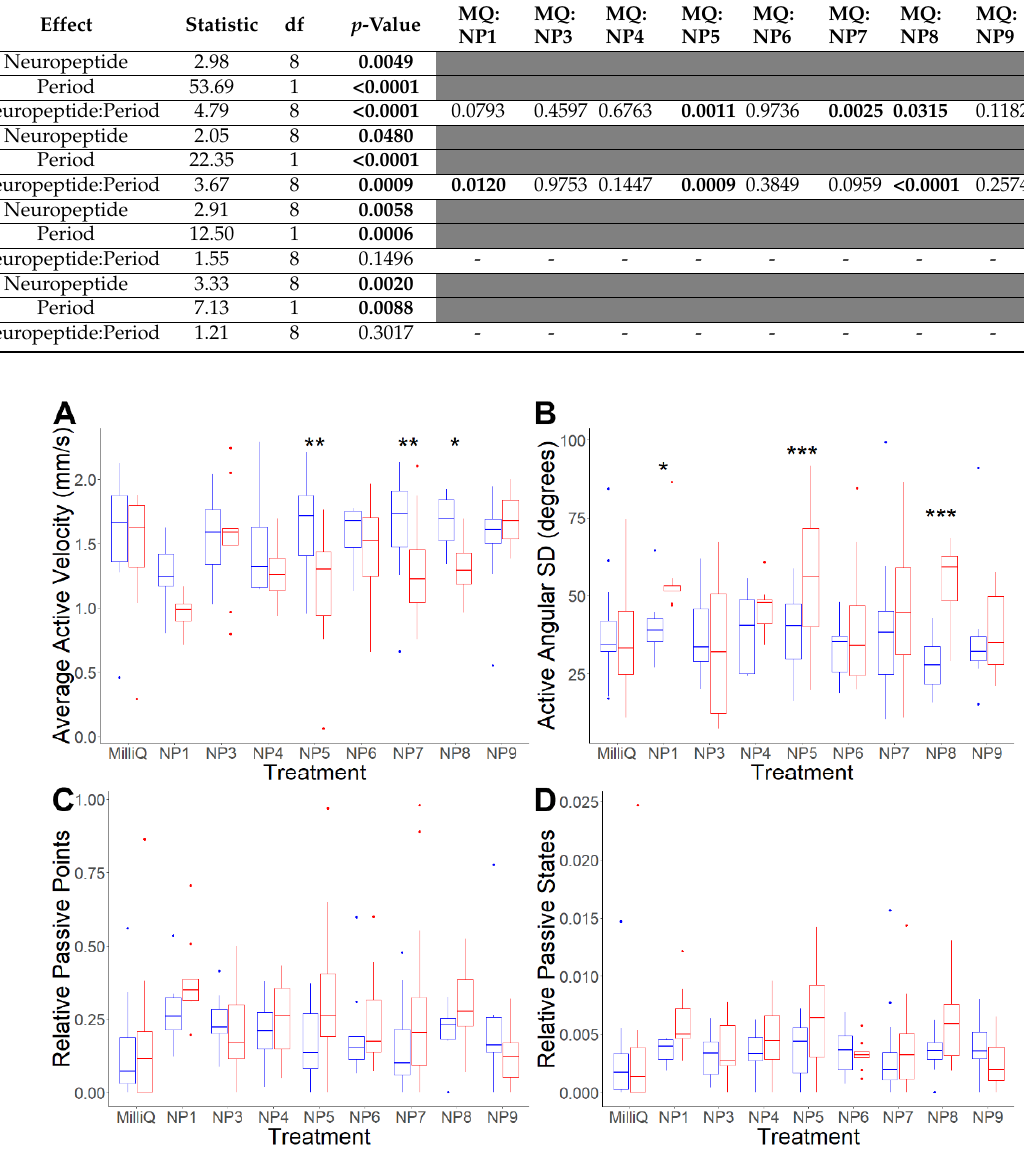
Table 2. Two-way ART ANOVA results, comparing the effects of S. mansoni cercarial exposure to NP1, NP3, NP4, NP5, NP6, NP7, NP8, and NP9 at 3 mg/mL in MilliQ water one min pre- and post-exposure. Test statistics, degrees of freedom, and p -values for the main effects of putative neuropeptide and period (pre- vs. post-exposure), and their interaction. If the interaction effect was significant, pairwise contrasts are included; testing analysed the significance of the change in behaviour pre- vs. post-exposure between MilliQ and each of the putative neuropeptides. Metrics: active velocity, active angular SD, relative number of passive points and states. Significant data ( p -value < 0.05) is in bold.